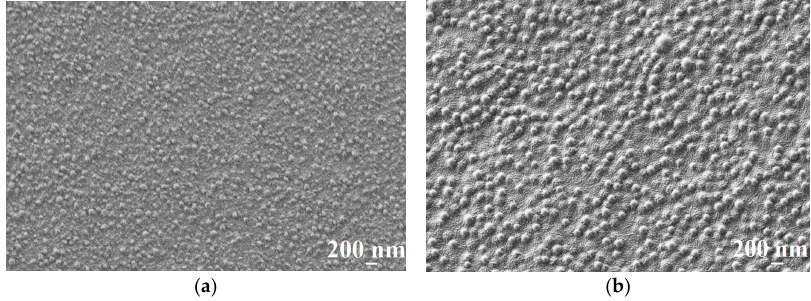
Figure 3. The SEM surface micrographs of ( a ) CS-PAN/UPM-20 and ( b ) CS-PS/UPM-20 membranes. The composite membrane cross-sections at different magnifications obtained by SEM are presented in Figure 4.